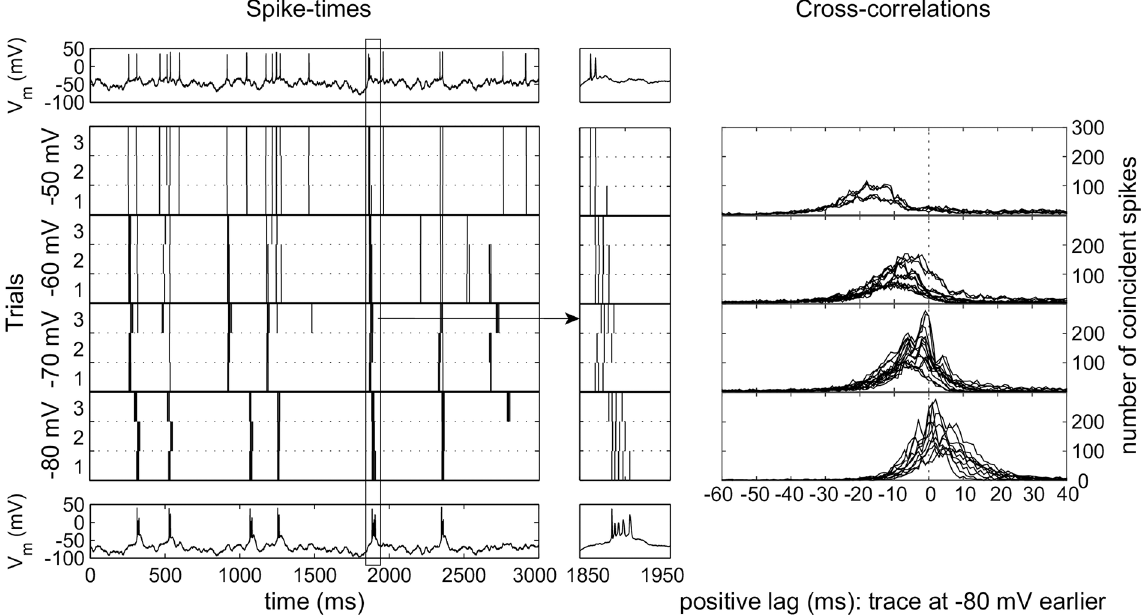
Fig 1. In vitro TCR neuron response to injected frozen noise. Left panel: Spike trains induced in a TCR cell by frozen noise with identical amplitude and various DC offsets; trace is a 3 s extract from a standard 300 s recording. Top: example trace at −50 mV. Bottom: example trace at −80 mV. Vertical bars in the panels in between mark the detected spikes in the 3 recorded replicates at 4 levels of depolarization, from top to bottom: −50, −60, −70 and −80 mV. The neuron responds earlier at more depolarized membrane potentials. Middle panel: 100 ms zoom of a single event starting at 1850 ms (zoom indicated in the left panel). Top and bottom show the event at −50 mV and −80 mV. Right panel: Cross- correllograms between a reference spike train at − 80 mV and the spike trains obtained in the same cell at the different membrane states. Recordings from 5 cells (=15 traces), resulting in 10 comparisons at −80 mV, 15 comparisons at −70 and at −60 mV; only 2 cells gave sufficient results at −50 mV (6 comparisons). On depolarization the peaks shift to the left, indicating that the neurons fire earlier.